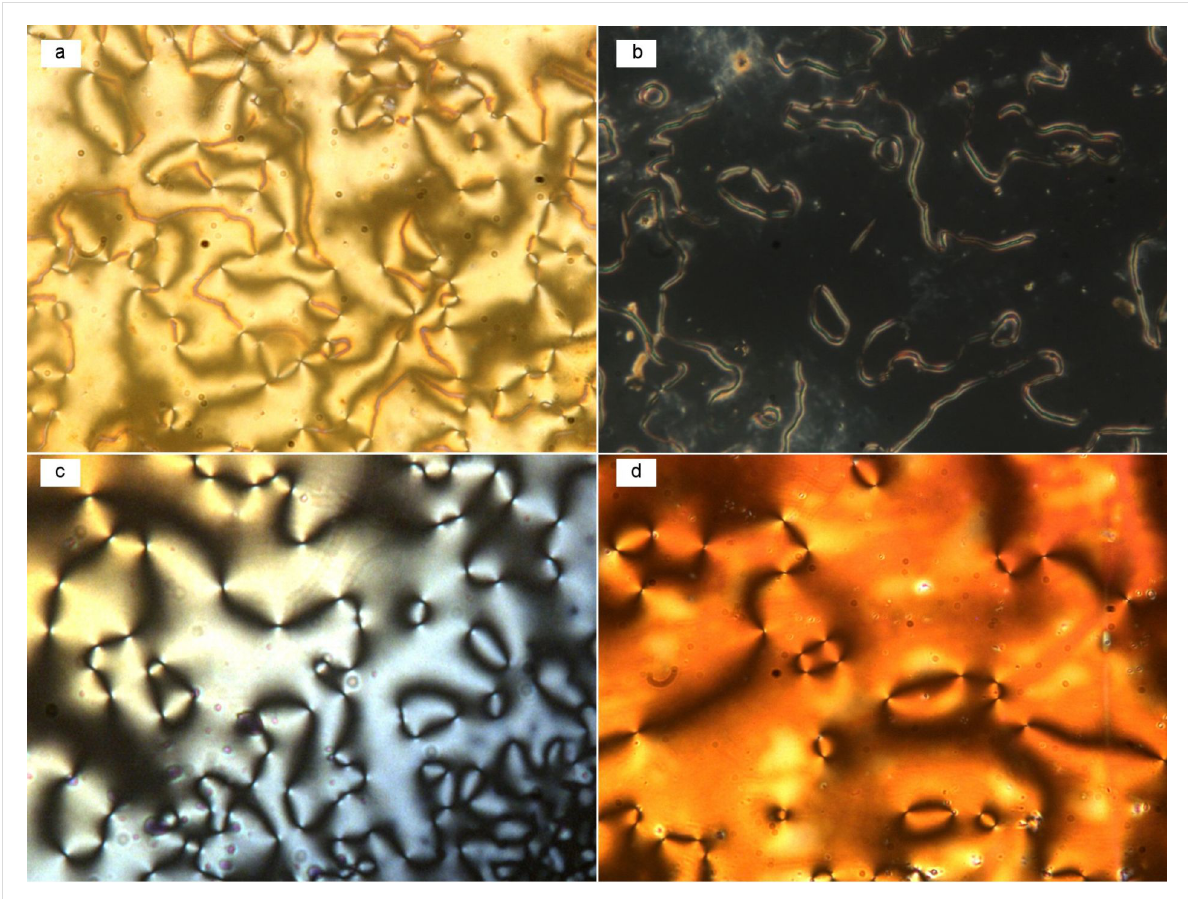
Figure 1: Microphotographs of compounds 1b and 1c in the nematic phase during the cooling cycle. (a) Birefringent Schlieren texture of 1b at 145 °C; (b) disappearance of birefringence and transformation to the homeotropic texture of 1b at 122 °C; (c) two-brush-defect Schlieren texture of 1c at 161 °C from I–N transition; (d) Schlieren texture with increased birefringence at 156 °C.